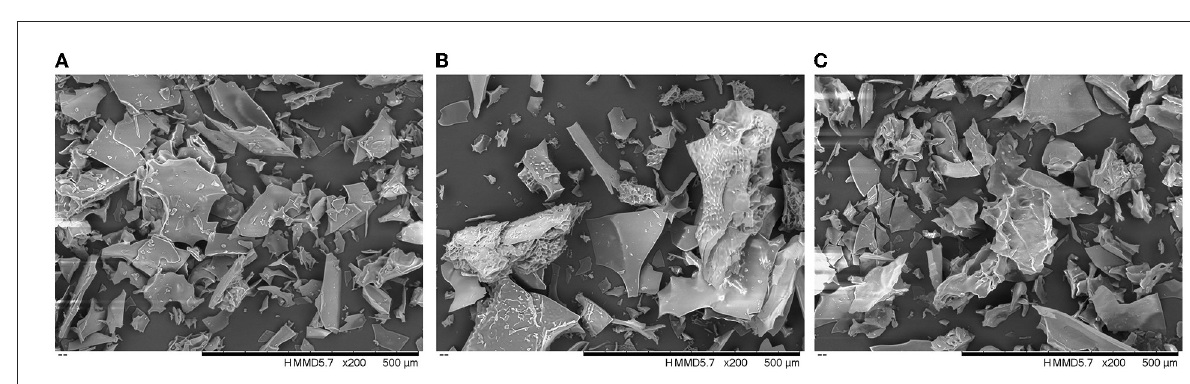
FIGURE4 Scanning electron microscopy (SEM) of WPI-MD-COF (A) , SPI-MD-COF (B) , and GE-MD-COF (C)